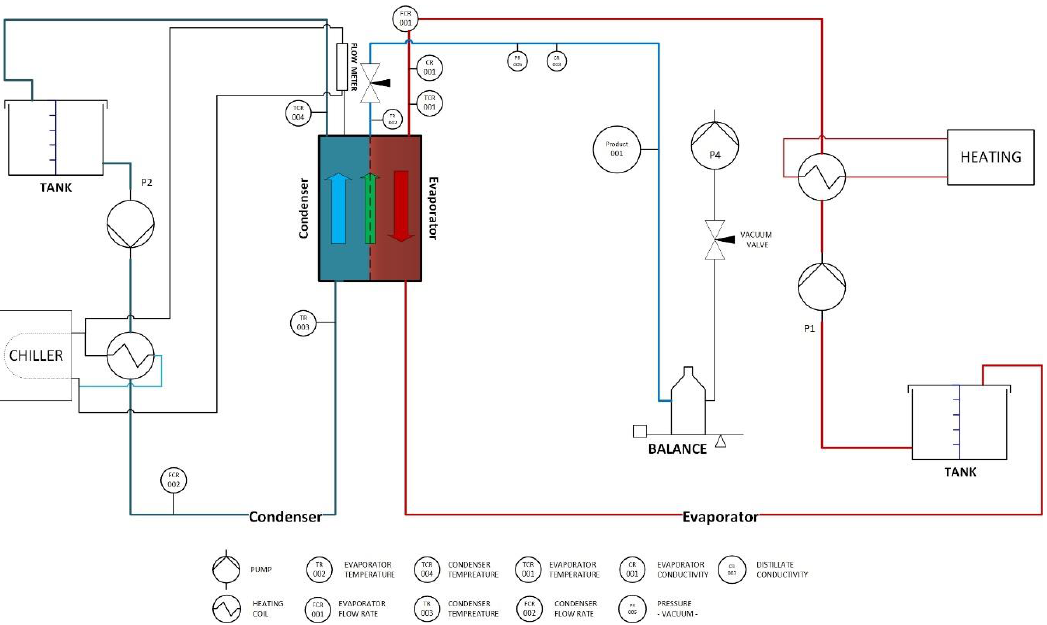
Table 1. The main components of synthetic seawater that were used in this study [32].